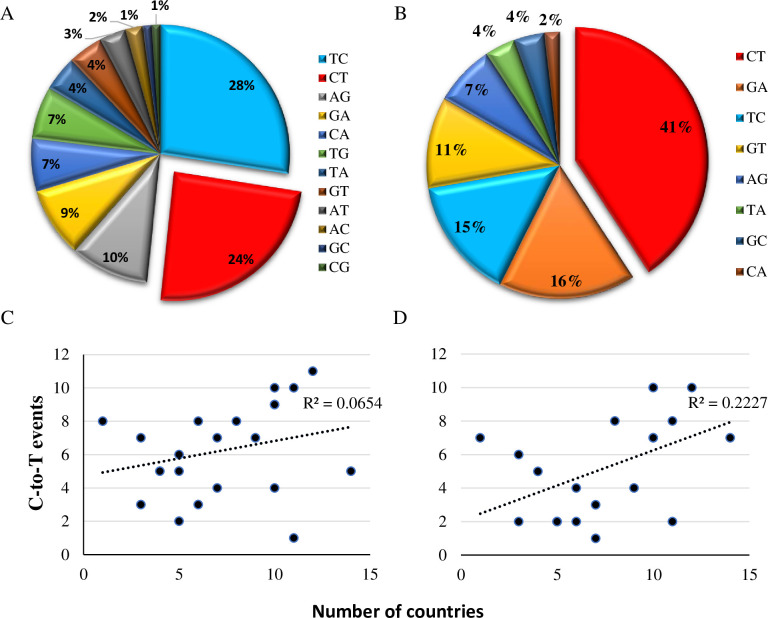
APOBEC mutations in HCoV-229E and SARS-CoV-2.(A-B) Mutation analysis of CoVs genomes. Percentage of all types of nucleotide transitions (mutation frequency >0.1) are presented in pie charts for HCoV-229E (A) and SARS-CoV-2 (B). (C-D) Correlation between independently occurring C-to-T events and the number of countries with mutations at the specific site. (C) Correlation in countries with moderate SARS-CoV-2 mortality (<99 deaths per million). (D) Correlation in countries with high SARS-CoV-2 mortality (> 99 deaths per million). Y-axis indicates the number of C-to-T alterations identified as independent events on the phylogenetic tree analysis. X-axis indicates the number of countries in which the event was identified in at least in one corona sample.